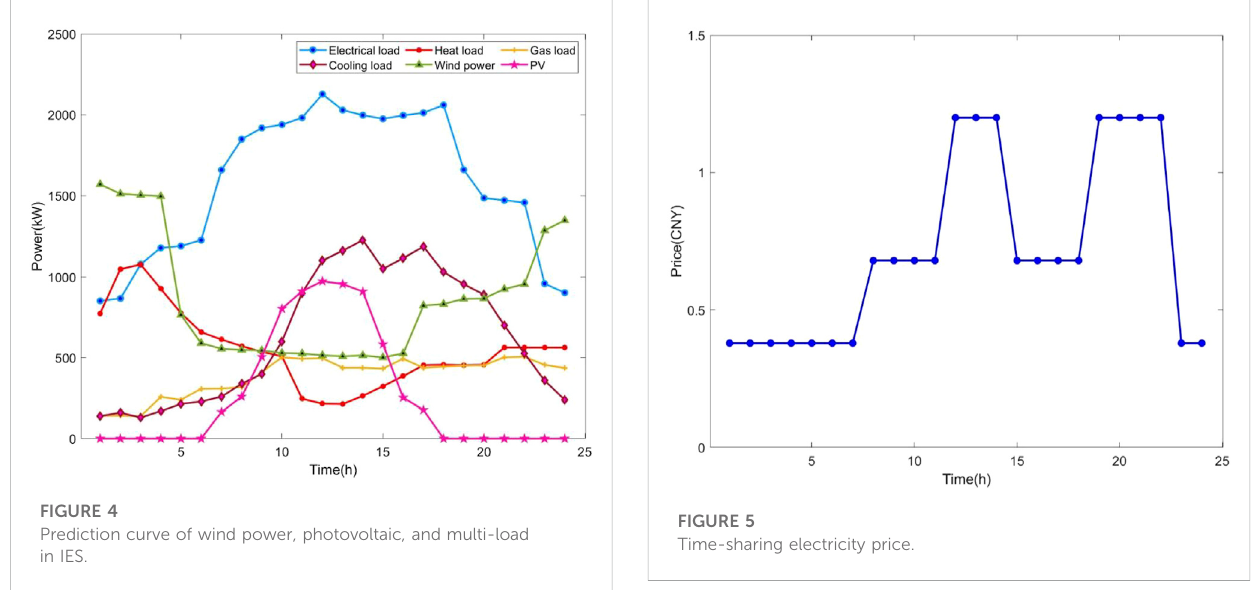
Figure 5. The parameters of each energy conversion equipment in the IESareshowninTable1.TheparametersofLAESareshownin Table2.